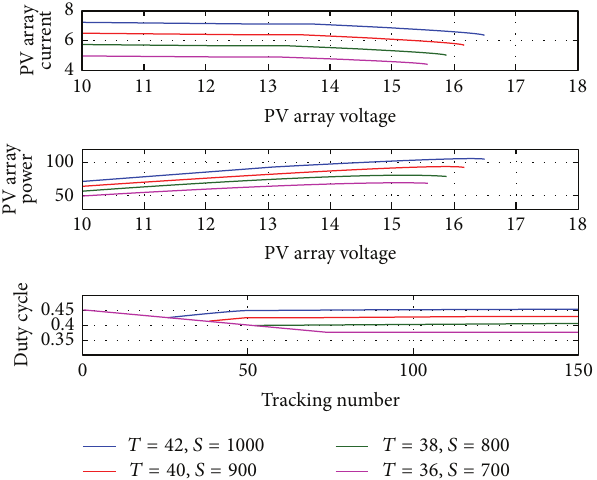
Figure10:ComparisonofINCandFOINCandVFOINCwithEVSS (power regulated to 90–106 W) (fixed irradiance).